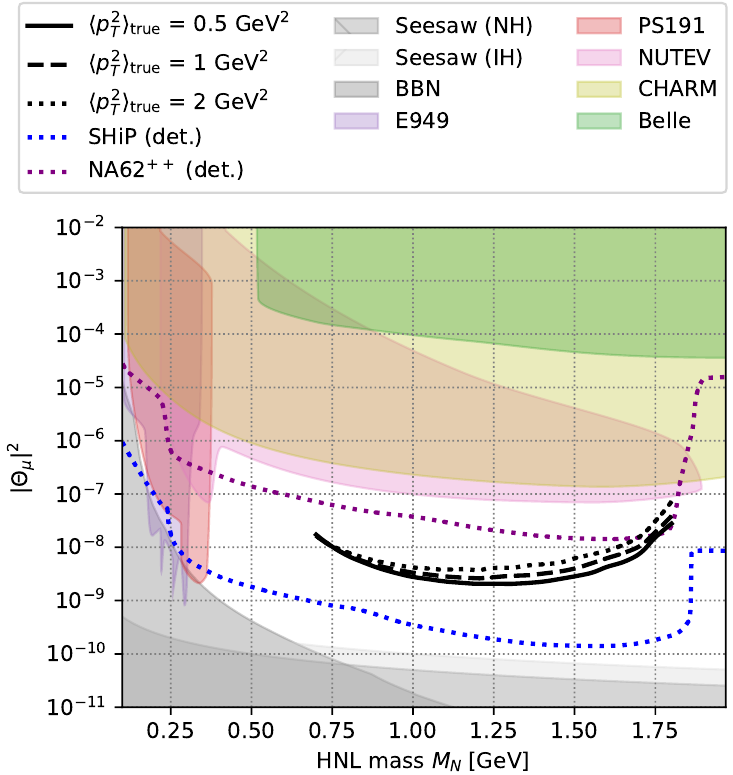
Figure 13. E(cid:11)ect on the LNV sensitivity (90% CL) of computing the classi(cid:12)cation accuracy on a test set generated with a di(cid:11)erent p to the muon. Black lines represent the model-selection sensitivity of SHiP for various true Here, the training set is always generated with